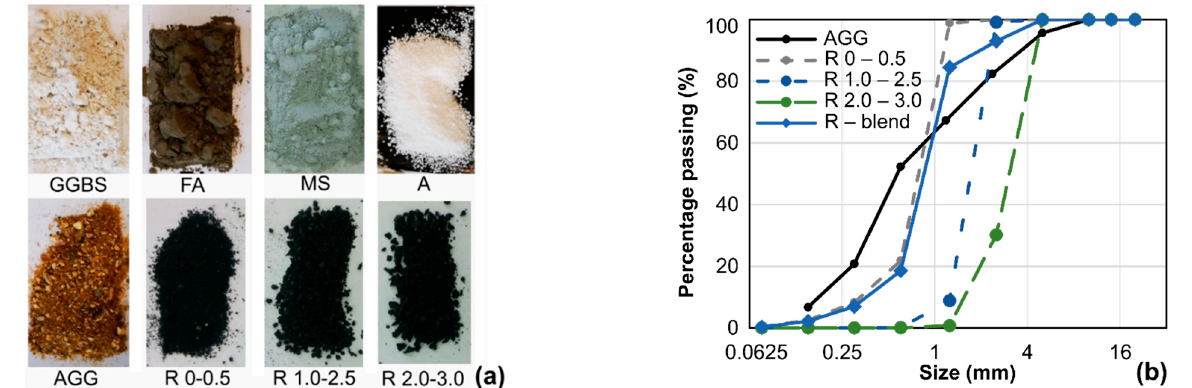
Figure 1. ( a ) mix constituents, ( b ) sieve analysis of mineral aggregates and rubber particles.